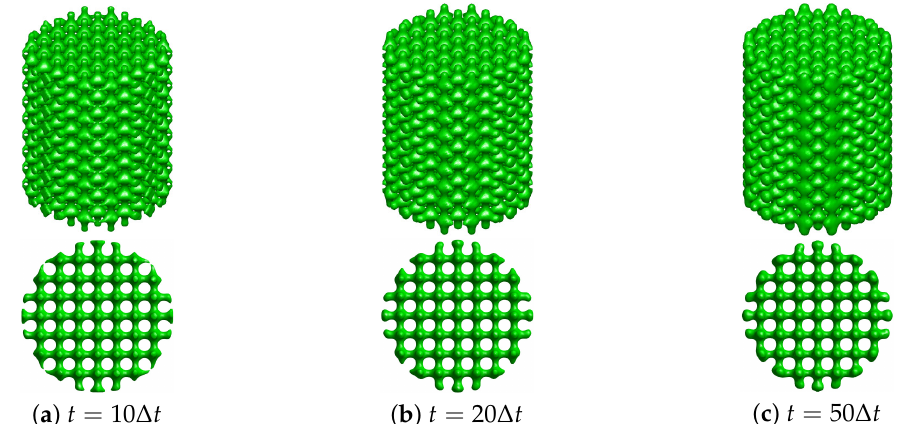
Figure 16. Cylindrical scaffolds using the P surface. Snapshots of phase separation at ( a ) t = 10 ∆ t , ( b ) t = 20 ∆ t , and ( c ) t = 50 ∆ t